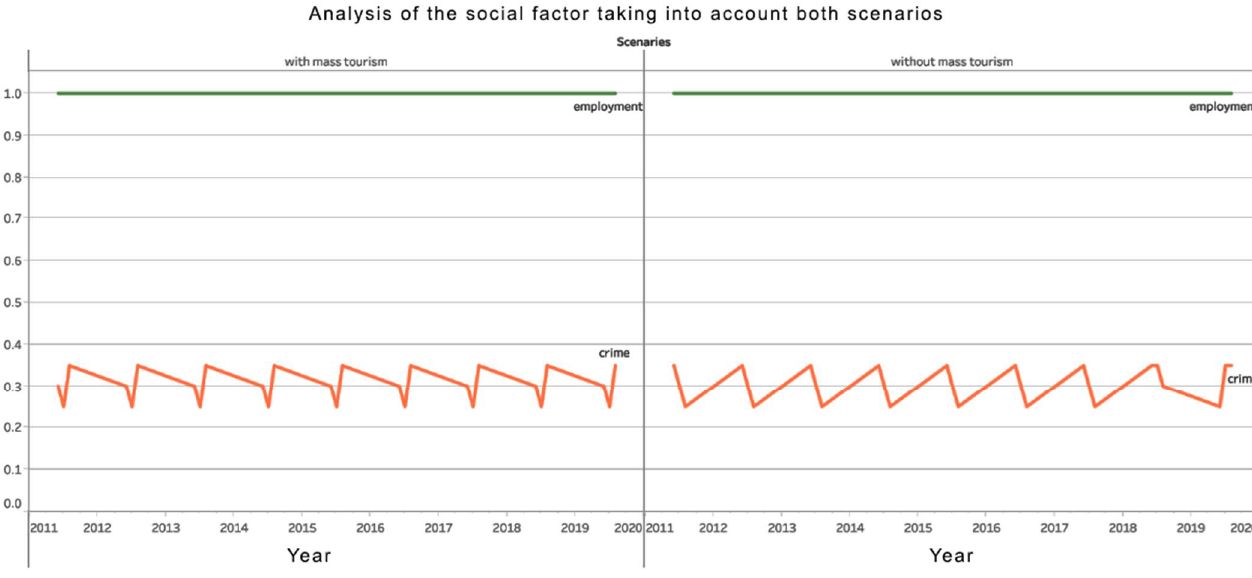
Figure 9. Analysis of social factor indicators for the two scenarios.